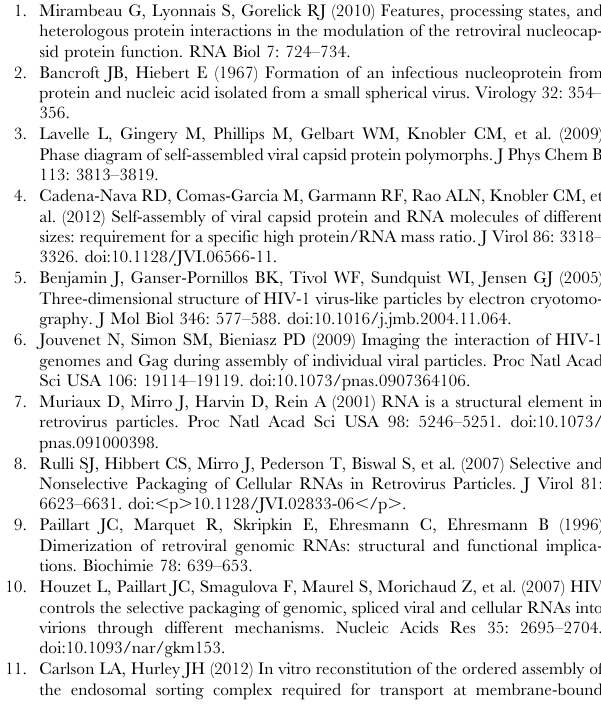
File S1 Figure S1. Figure S2. Figure S3. Figure S4. Figure S5. Methods